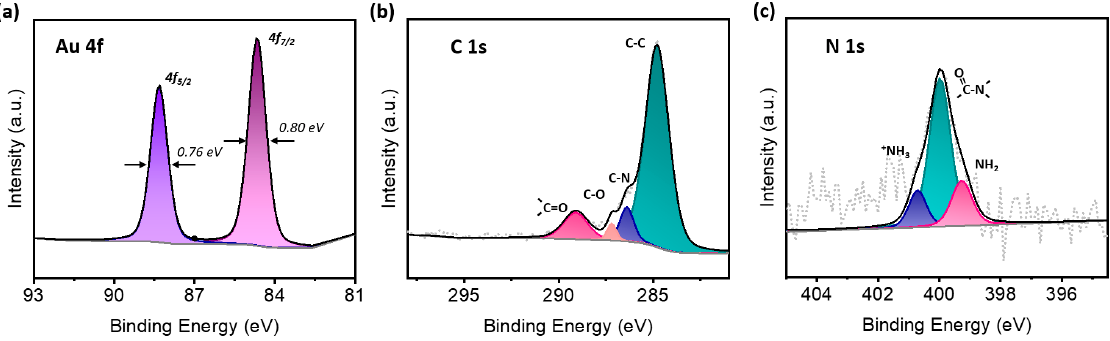
Figure 3. XPS of electrodeposited AuNP-biopolymer nanocomposite. ( a ) Au 4f spectra, ( b ) C 1s spectra, and ( c ) N 1s spectra.